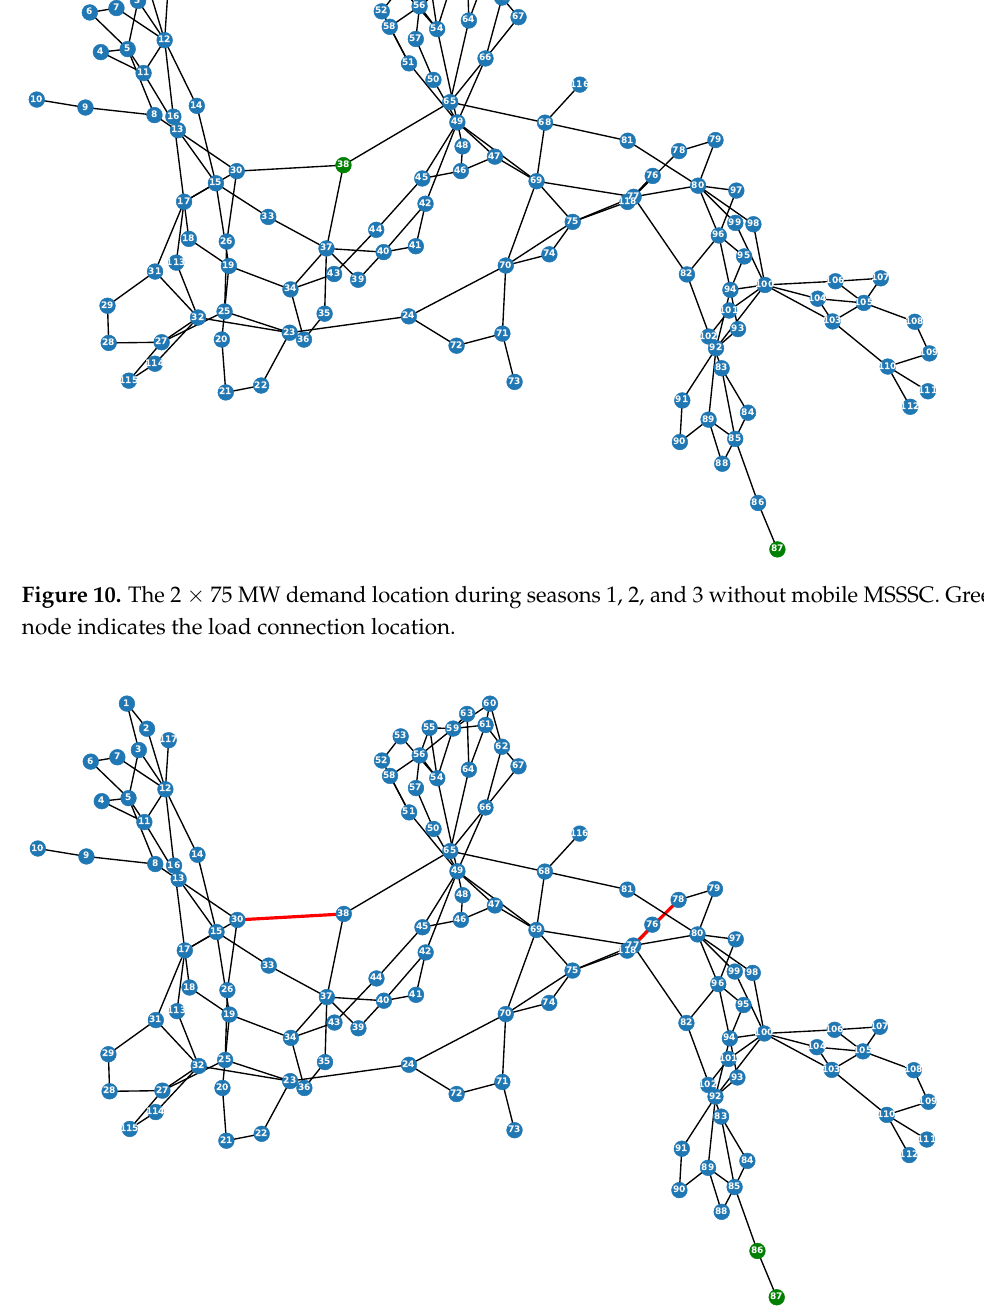
Figure 11. The optimal 2 × 75 MW demand and mobile MSSSC allocation during seasons 1 and 3. Red lines indicate the mobile MSSSC deployment locations; green node indicates the load connec- tion